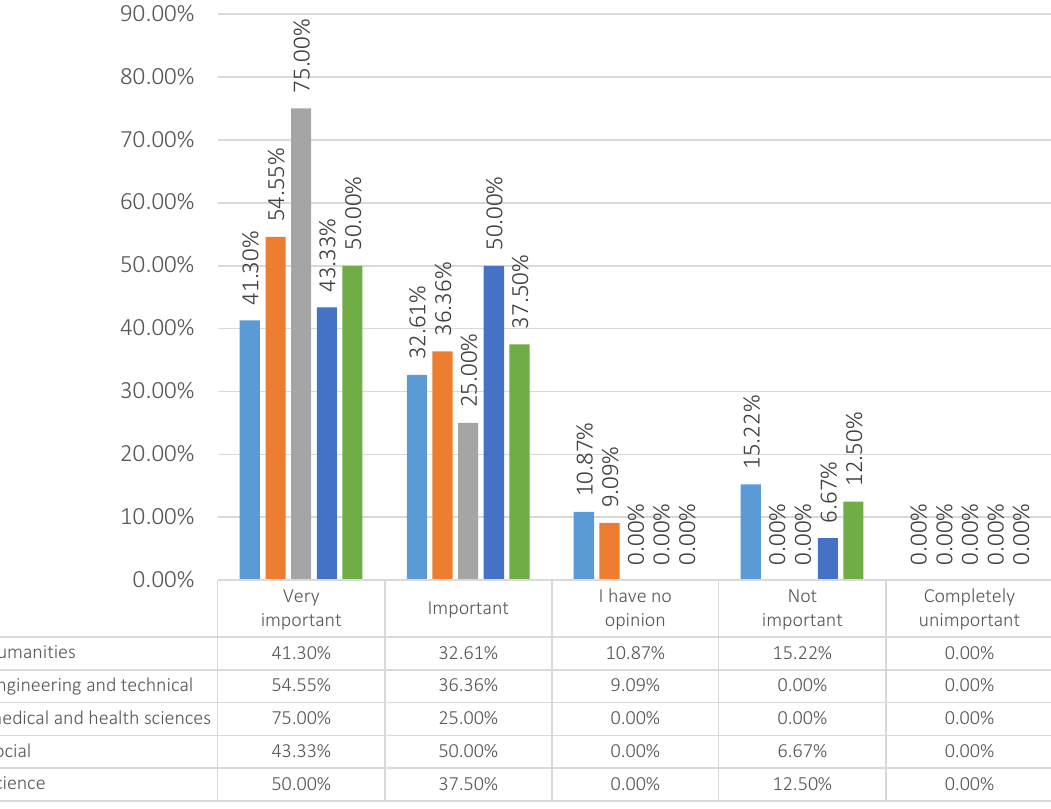
Figure 7. Assessing the value of integrity in the group of supervisors, broken down by education